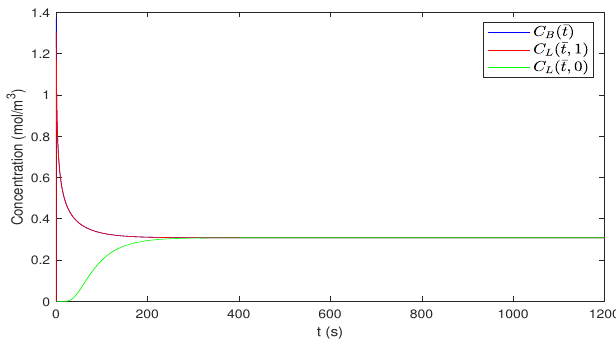
Figure 9. Dynamics of the concentrations obtained from the simplified model ( α/β ≈ 10) for the data reported in [16].